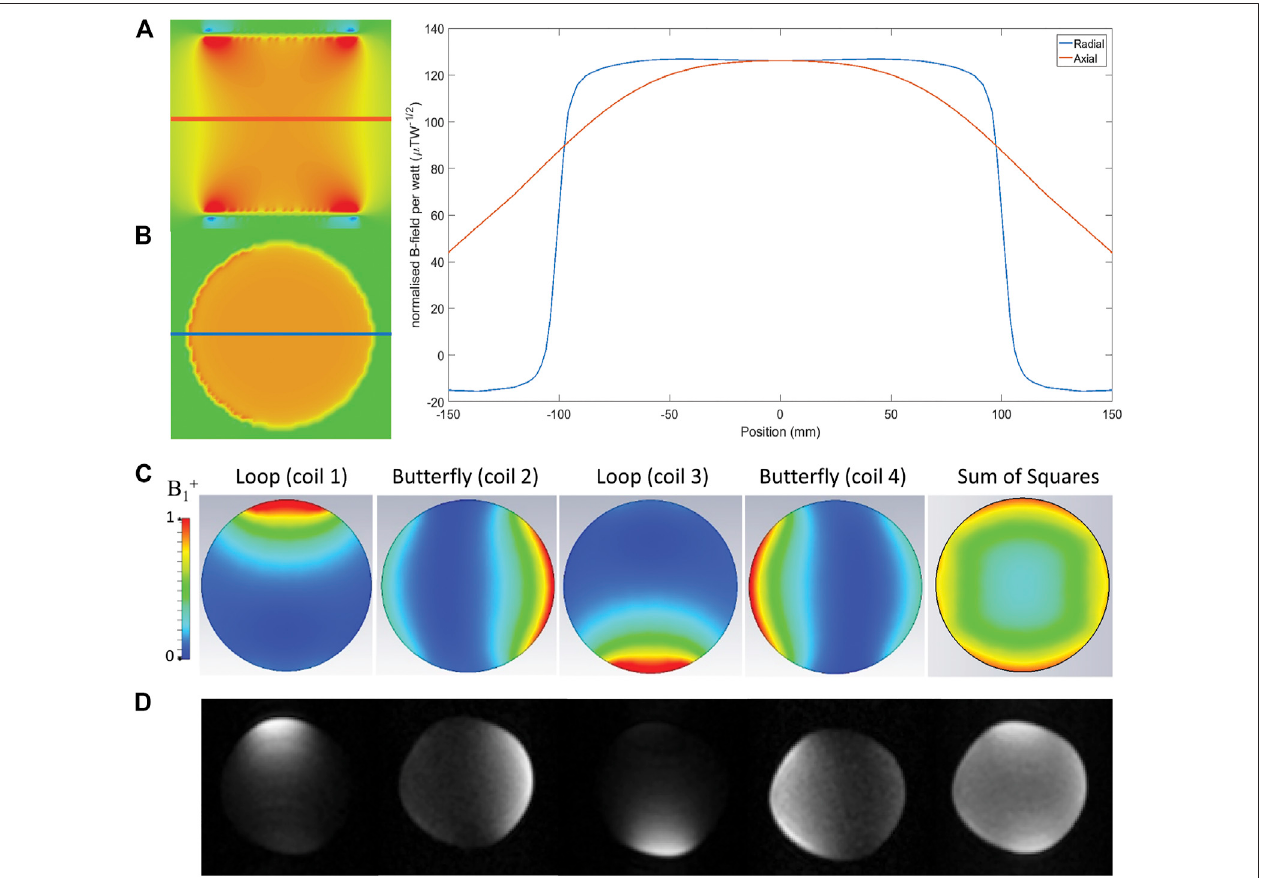
FIGURE3| Simulated fi eldsofthetransmitcoil,axial (A) andtransverse (B) slicesareshowntogetherwithvaluesofthemagnetic fl uxdensitytakenalongthecentre lines. The fi elds corresponding to the receive array are depicted in the bottom images (C) , which shows a CST model of the array loaded by a cylindrical phantom with ε (cid:2) 61, σ (cid:2) 0.029 S/m,at 2.15 MHz. TheB1 isnormalized to1 W inputpower. (D) phantom measurementsobtainedwithacylindrical phantom ofthesamedimensions as the simulated phantom, the following acquisition parameters were used: 200 ( z : right-left) × 200 ( y : posterior-anterior) × 300 ( x : head-feet) mm 3 , data matrix: 100 × 100 × 60, TR/TE: 200/15 ms, echo train length: 6, scan duration 3 min 33 s.